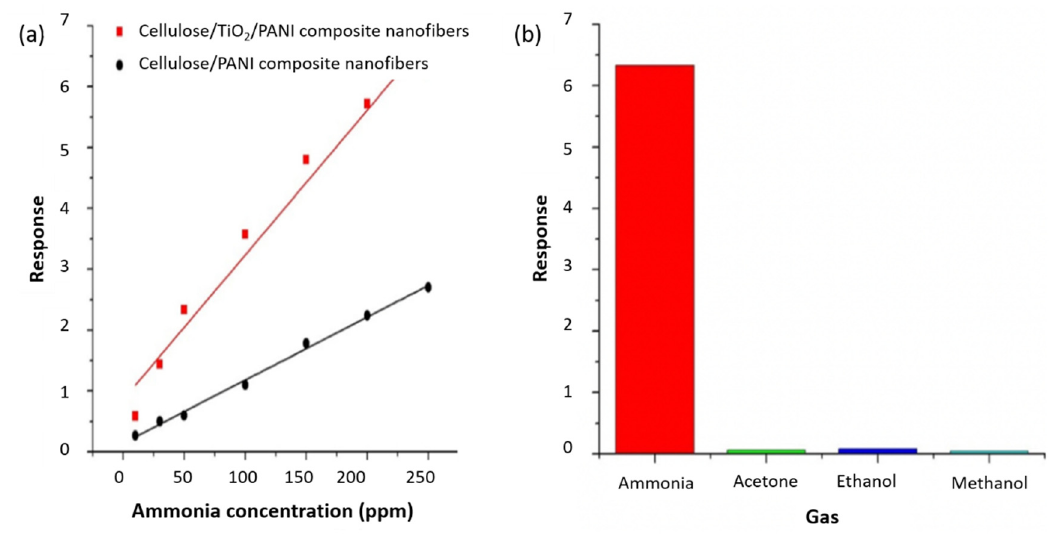
Figure 11. SEM images of CNF ( a ), CNF/TiO 2 ( b ), CNF/PANI ( c ) and CNF/TiO 2 /PANI composite. ( d ). Reproduced from ref. [117].